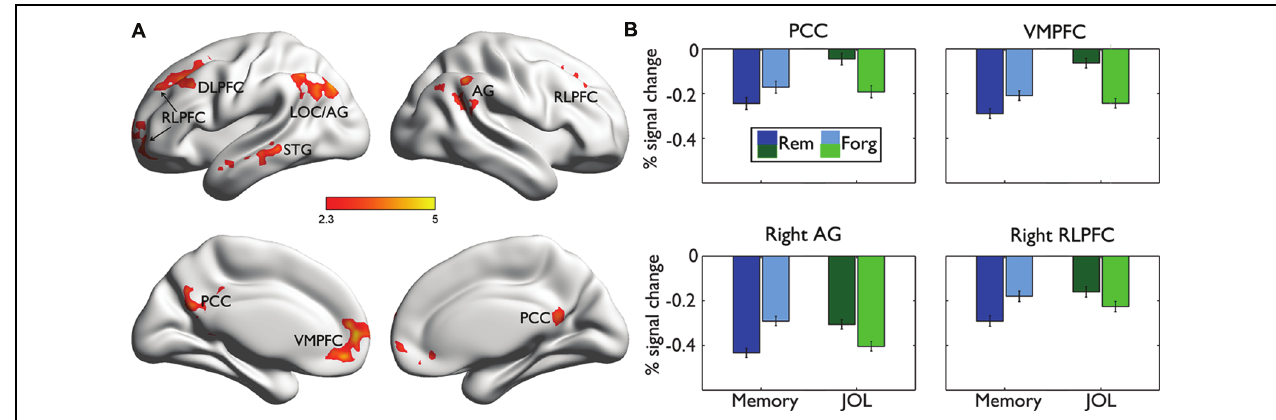
FIGURE 5 | Comparisons of brain responses underlying subsequent memory performance and JOL. (A) Brain regions showing significant differences between the subsequent memory effect and the subsequent JOL effect are rendered onto a population-averaged surface atlas (Xia et al., 2013). All activations were thresholded at Z > 2.3 (whole-brain corrected p < 0.05). (B) Bar graphs of the percentage signal change in each ROI, as a function of subsequent memory or JOL. Error bars denote within-subjects standard errors.